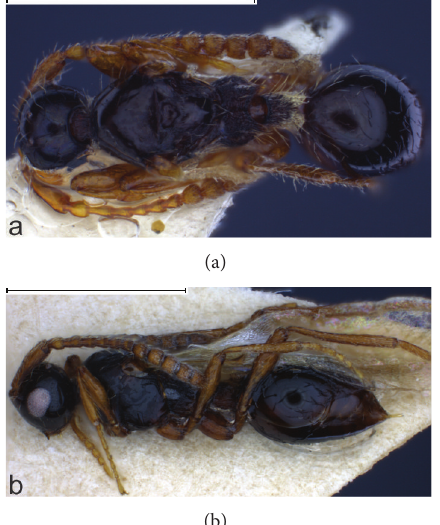
Figure 8: Trichopria formicans female (a) in dorsal view and (b) lateral view. Scale: